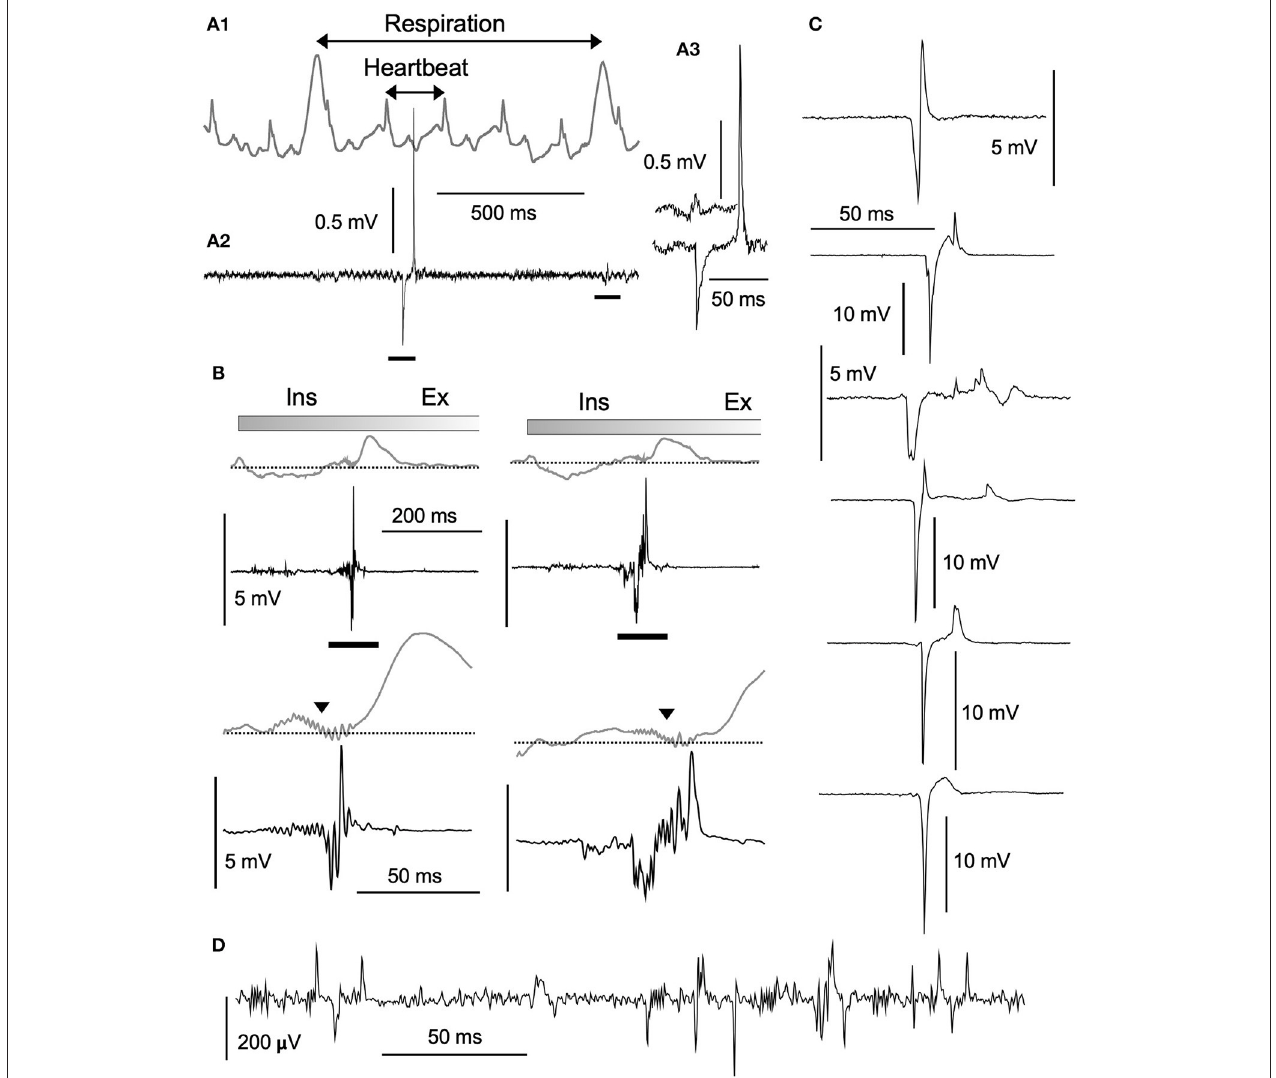
FIGURE 2 | Structure of high-amplitude potentials. Neuronal high-amplitude potentials recorded extracellularly in vivo using a standard glass electrode in the vagal complex. (A1) Cardiorespiratory activities recorded simultaneously with a piezoelectric transducer (PZT) attached to a thorax (gray wave in an upper row). Cardiorespiratory cycles (“Respiration” and “Heartbeat” cycles indicated by double-headed arrows) were confirmed by a visual inspection of thorax movement. A simultaneously recorded neuronal activity ( A2 , lower row) contains a high-amplitude potential and a typical low-amplitude wave ( A3 , bars in A2 ). (B) Polyphasic high-amplitude potentials synchronized with the inspiratory (Ins) phase of each respiratory cycle. The polyphasic potential activity is reflected as synchronized jitter in cardiorespiratory PZT traces (triangles in lower rows expanded from bars in upper rows). Varied shapes of high-amplitude potentials ranging several millivolts in amplitude, as depicted in (B) (synchronized with respiratory cycles) and (C) (asynchronous with cardiorespiratory cycles), look like enlarged copies of typical low-amplitude potentials ranging hundred microvolts (D) . Burst-like polyphasic activities are associated with both types of potentials. Ex, expiratory phase of a respiratory